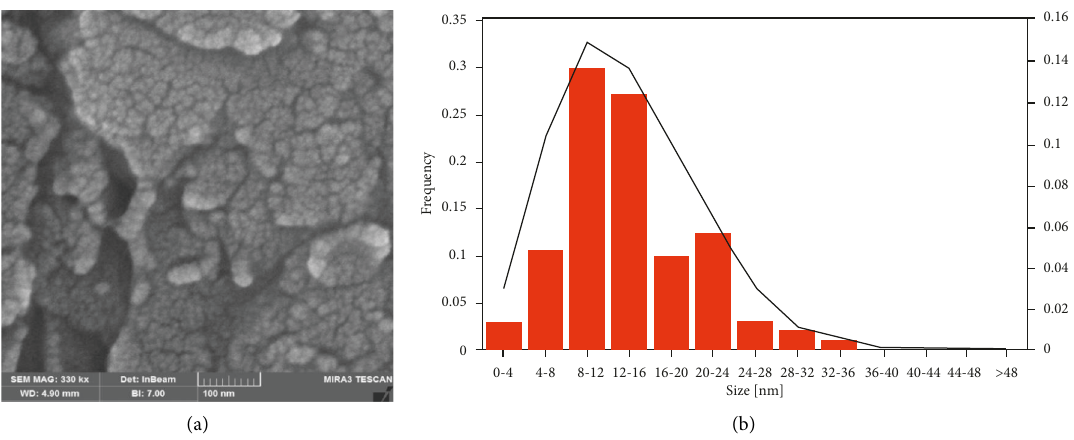
Figure 3: Scanning electron microscope images of selenium NPs (a); histogram of particle size distribution curve of selenium NPs (b).